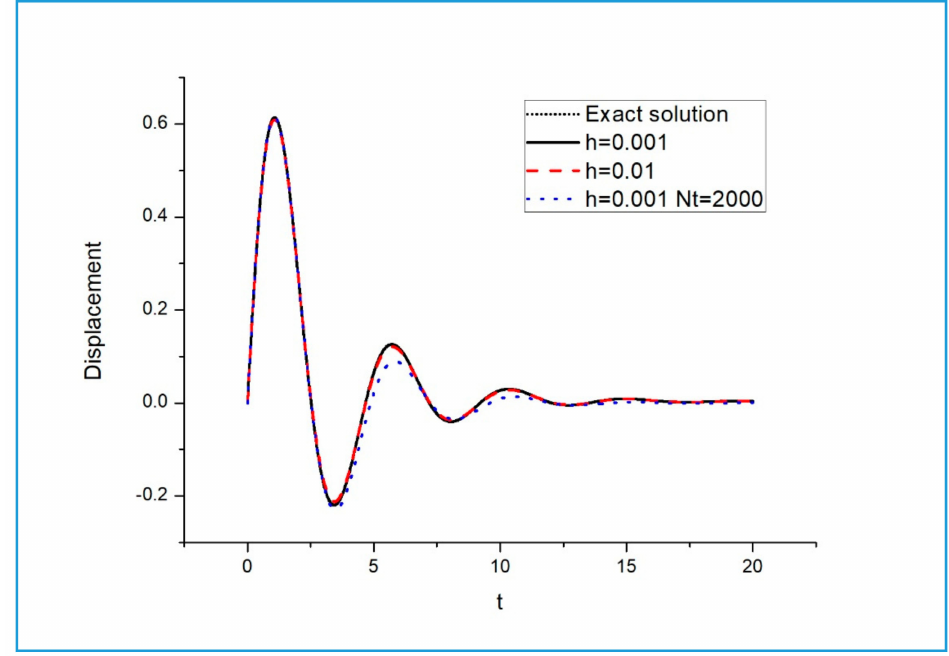
Figure 5. Displacement response for di ff erent methods (Laplace transform method, original definition method and SMP method).